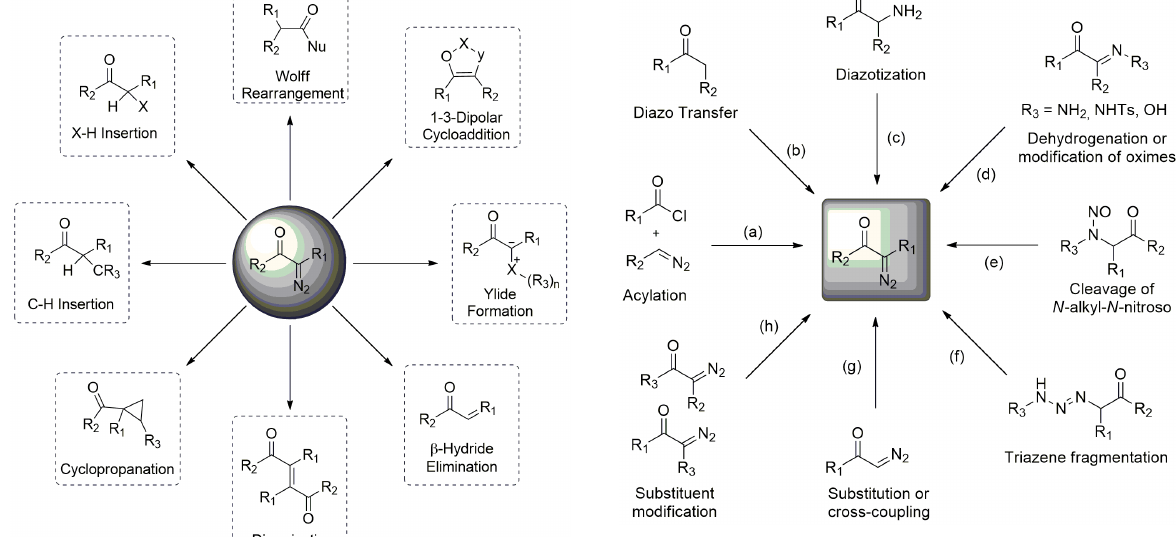
Figure 2 - Common methods to prepare diazocarbonyl compounds.